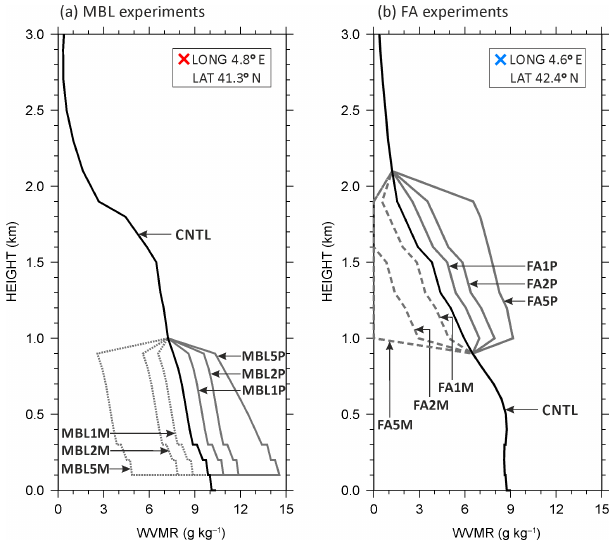
Figure 5. Vertical profiles of WVMR in the centre of the initial sensitivity bubble used in (a) MBL experiments and (b) FA exper- iments. Black solid lines are vertical profiles of the CNTL run at the same grid point as in MBL and FA. Solid grey lines represent experiments in which WVMR was augmented, while dashed grey lines represent experiments for which WVMR was reduced. The centre location of the initial sensitivity bubble used in MBL and FA is shown in Fig.